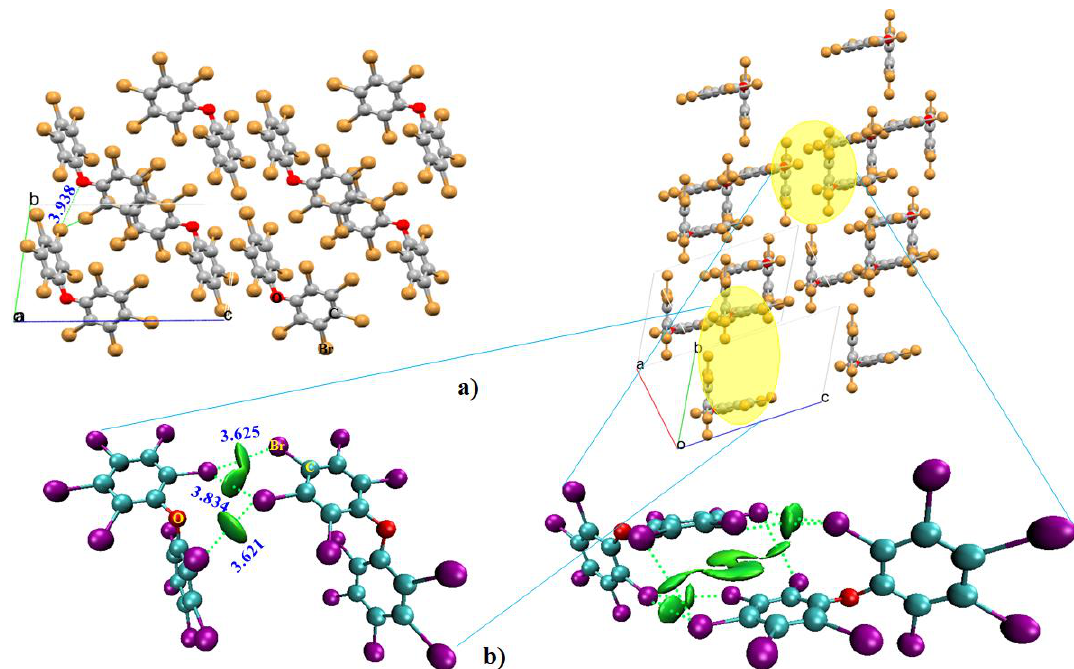
Figure 19. ( a ) Two views of the ball-and-stick model of the crystal structure of 1-(2,3,4,5,6- pentabromophenoxy)-2,3,4,5,6-pentabromobenzene (CSD ref: COCDED). ( b ) IGM isosurface plot (isovalue = 0.005 a.u.) illustrating possible halogen-center intermolecular bonding scenarios. Selected bond distances are shown in